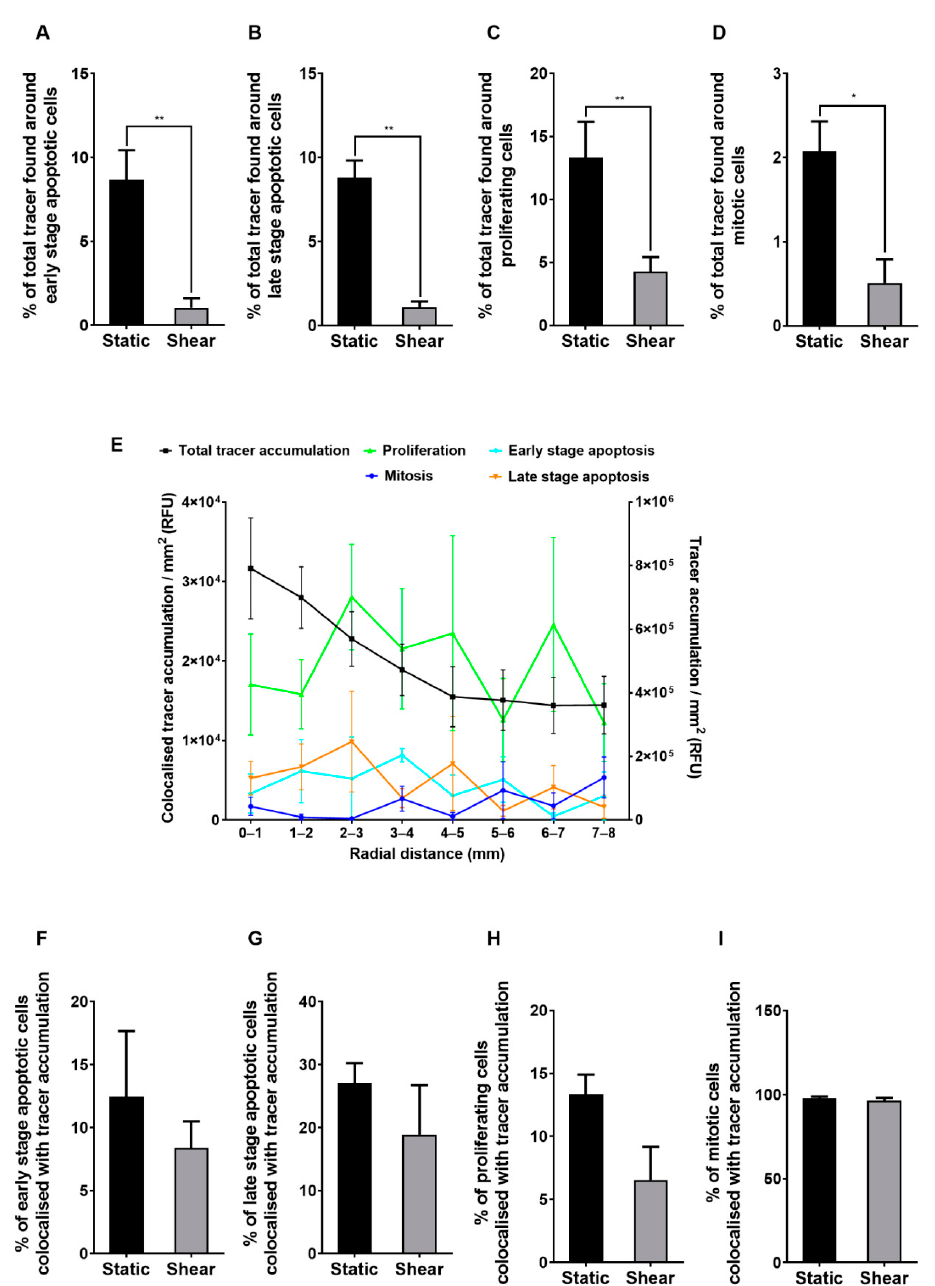
Figure 5. Percentage of total tracer accumulation due to cells undergoing ( A ) early-stage apoptosis, ( B ) late-stage apoptosis, ( C ) proliferation and ( D ) mitosis. ( E ) Total FITC-avidin accumulation and its accumulation near apoptotic and proliferating cells as a function of radial distance from the centre of sheared wells. Percentage of cells undergoing ( F ) early-stage apoptosis, ( G ) late-stage apoptosis, ( H ) proliferation and ( I ) mitosis which colocalised with areas of FITC-avidin accumulation under static conditions or shear. Mean ± SEM, n = 5